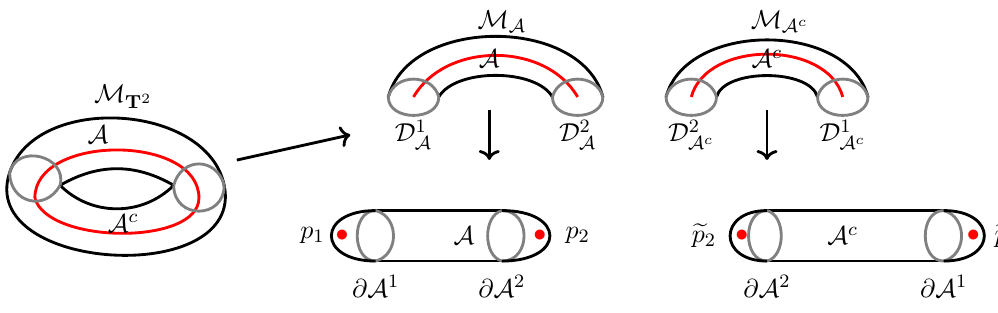
Figure 5 . Cutting the solid torus M having a Wilson loop in representation R i produces two T 2 handlebodies M A with boundary A [ D 1 [ D 2 and M A c with boundary A c [ D 1 [ D 2 . The A A A c A c Wilson line induces marked point p 1 carrying representation R i on D 1 and p 2 carrying the dual A representation of R i on D 2 . It likewise induces marked point p 2 carrying representation R i on D 2 e A A c and p 1 carrying the dual representation of R i on D 1 . The boundary condition on @ A 1 can be e A c identi(cid:12)ed with the marked point p 1 and the representation R i . Similar statements can be made